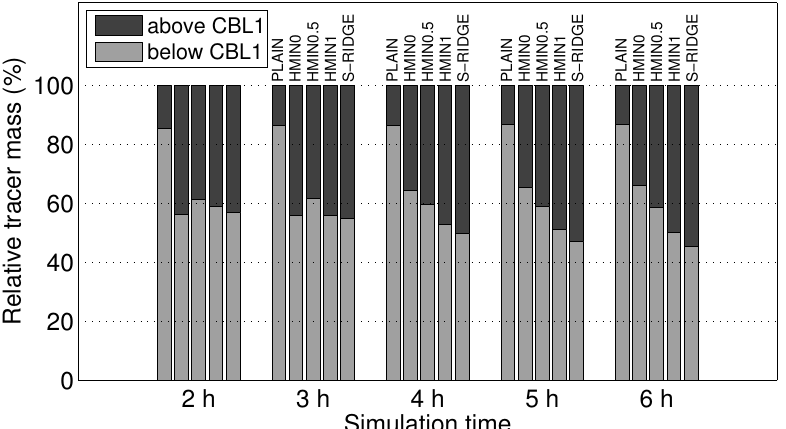
Figure 9. Relative tracer mass located above (dark gray) and below (light gray) the reference CBL height (CBL1) as a function of time. A tracer has been constantly emitted near the surface over the half space of the mountain range within the region of − 30 km ≤ x ≤ 0km (see Fig. 8). Shown are all simulations (from left to right) between 2 and 6h: PLAIN, HMIN0, HMIN0.5, HMIN1, and S-RIDGE.